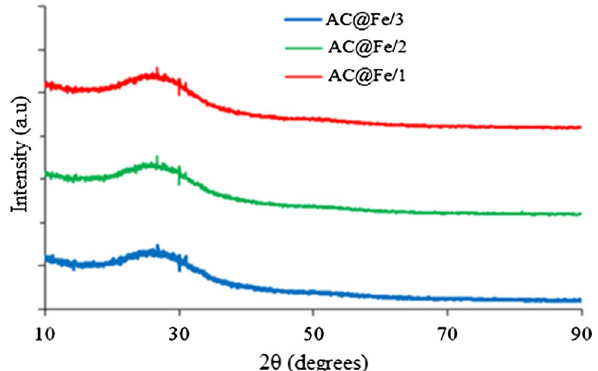
Fig. 3 XRD spectra of heterogeneous catalysts AC@Fe/1, AC@Fe/2 and AC@Fe/3